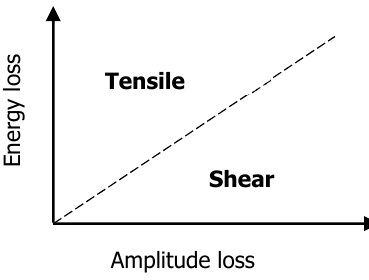
Figure 14. Amplitude and energy losses of the AE activities.